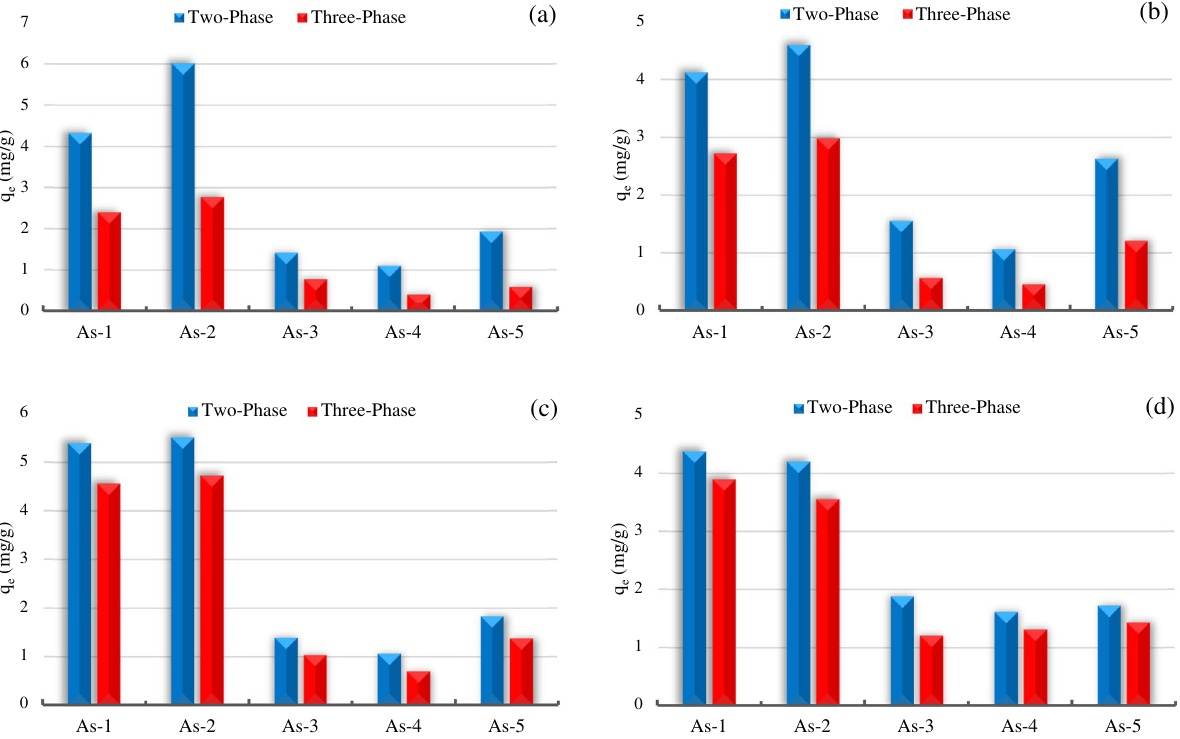
Figure 8. The impact of water on the asphaltenes uptake by ( a ) magnetite NPs, ( b ) hematite NPs, ( c ) calcite NPs, ( d ) dolomite